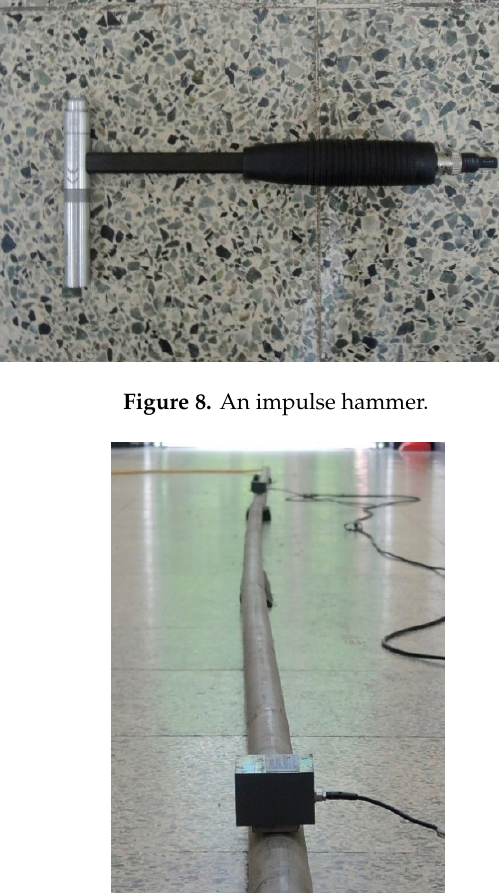
Figure 9. The placement of two AE sensors along the pipe.